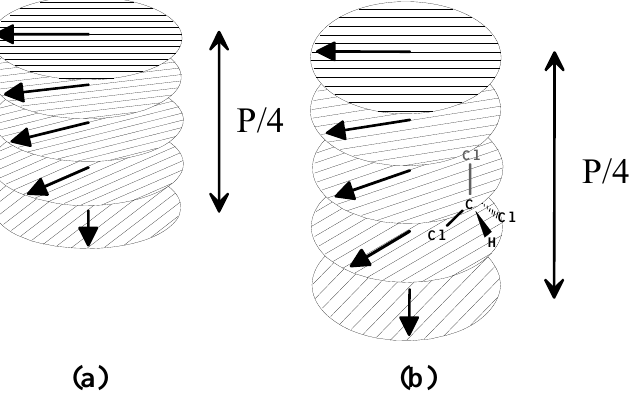
Figure 1. Representation of cholesteric liquid crystals encapsulating analyte molecule.